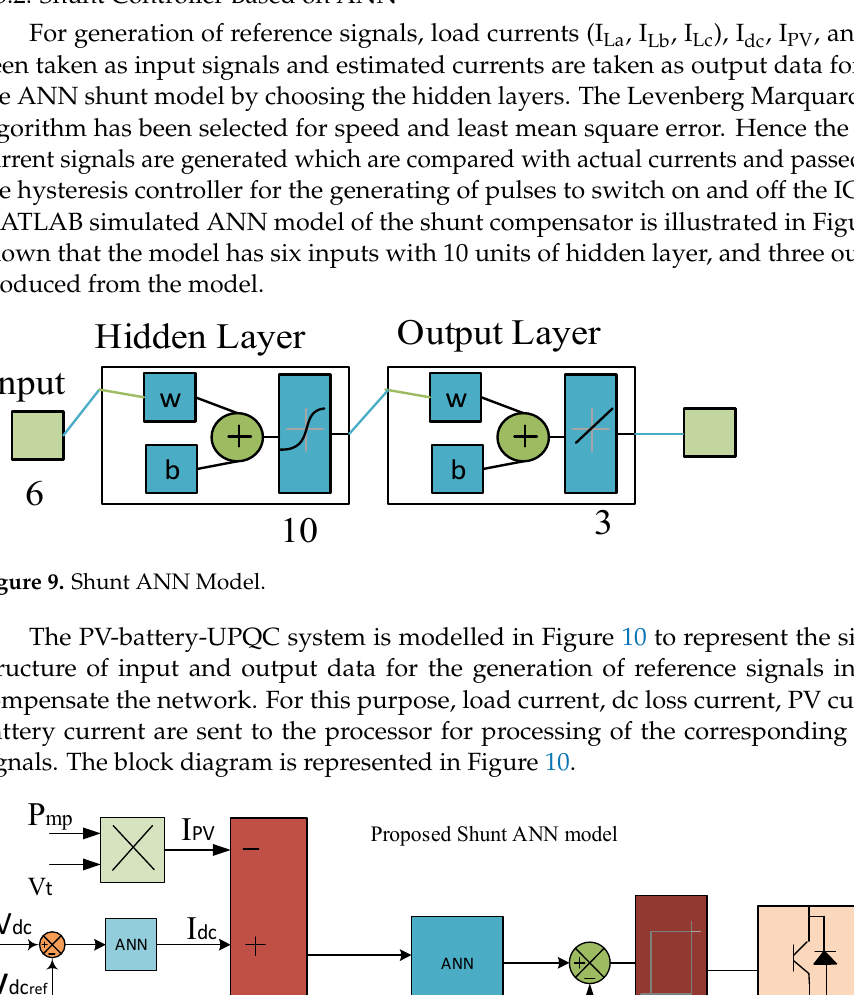
Figure 8. Capacitor Balancing ANN Structure.